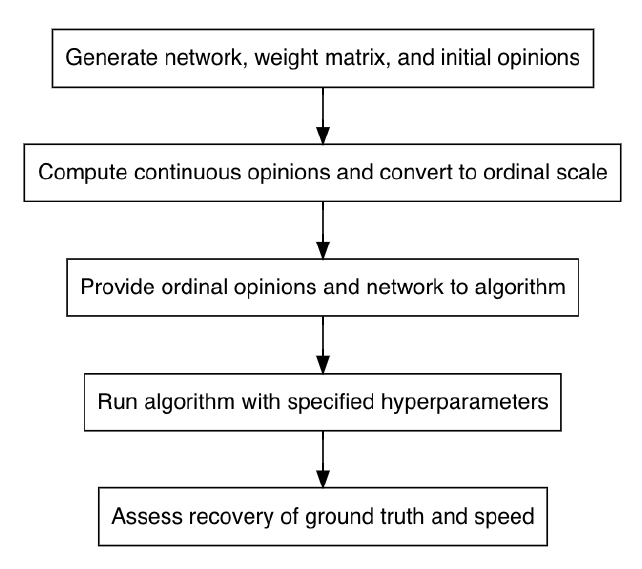
Figure 2. Procedure for algorithm